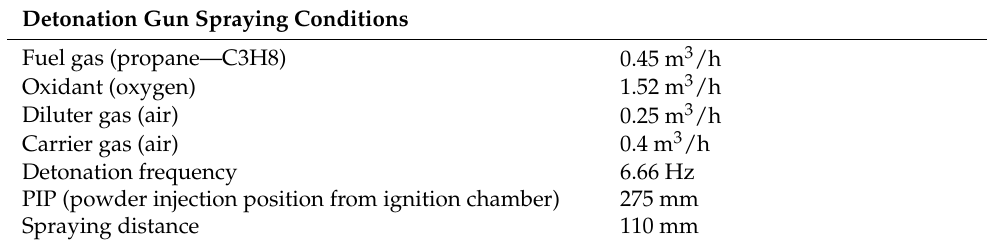
Table 1. DGS conditions for the 5–160 µ m particles size of the Fe40Al at.% powder sprayed into water. Detonation Gun Spraying